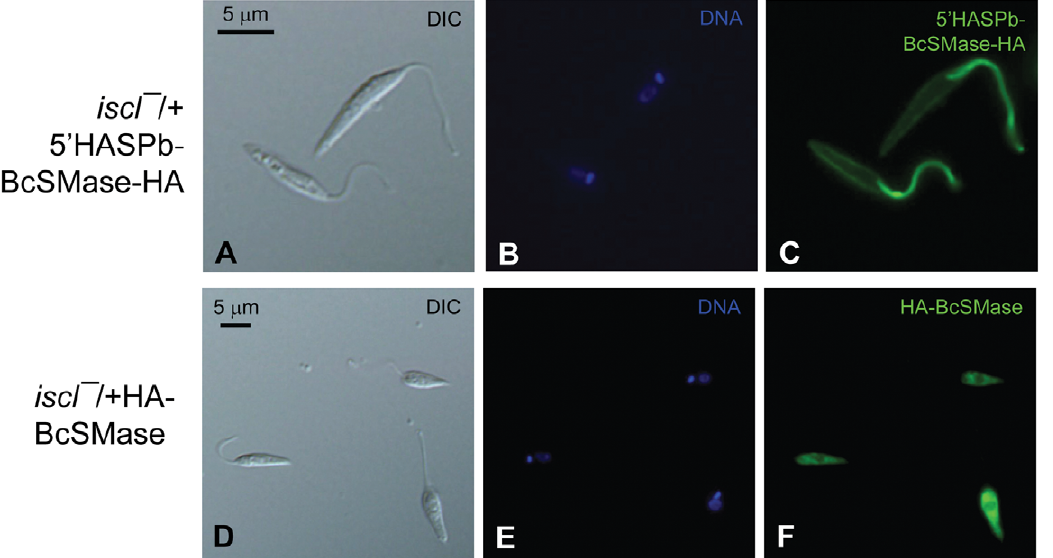
Figure 7. Cellular localization of HA-tagged BcSMase. Late log phase promastigotes of iscl 2 / + HA-BcSMase ( A–C ) or iscl 2 / + 5 9 HASPb-BcSMase- HA ( D–F ) were labeled with a monoclonal anti-HA antibody followed by anti-mouse IgG-FITC. ( A , D ) DIC images; ( B , E ) Hoechst staining of DNA; ( C , F ) anti-HA staining. Control cells that were labeled with secondary antibody only did not show any green fluorescence (data not shown). doi:10.1371/journal.pone.0031059.g007 PLoS ONE |